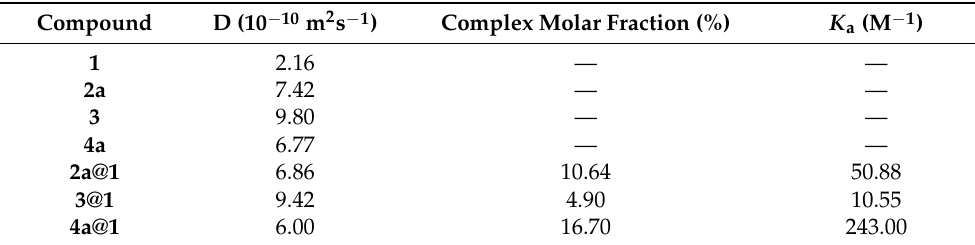
Table 3. Diffusion coefficients (D) of 1 , 2a , 3 , 4a , 2a @ 1 , 3 @ 1 , and 4a @ 1 ; the complex molar fraction; and the association constant ( K a ) of 2a @ 1 , 3 @ 1 , and 4a @ 1